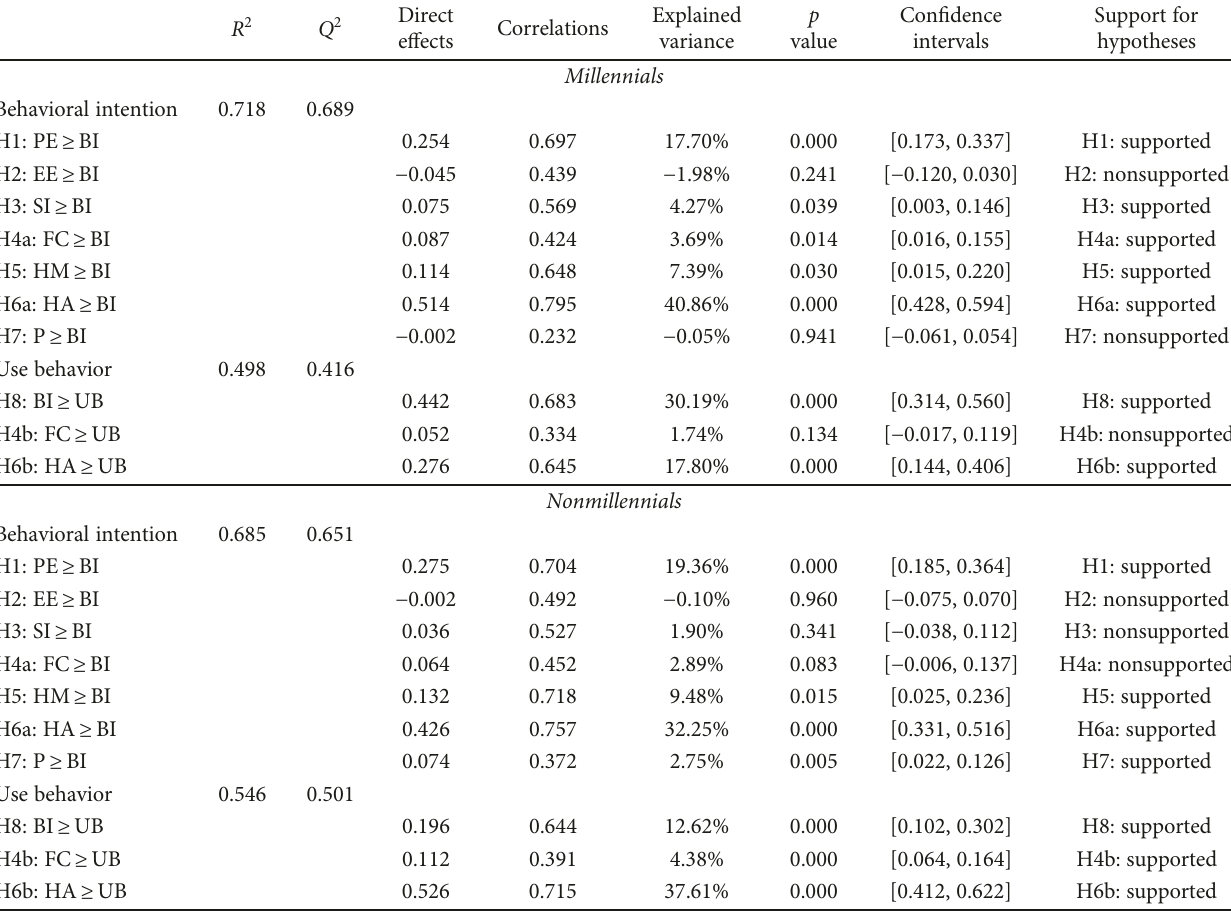
Table 5: E ff ect of endogenous variables, p values, and support for the hypotheses. R 2 Q 2